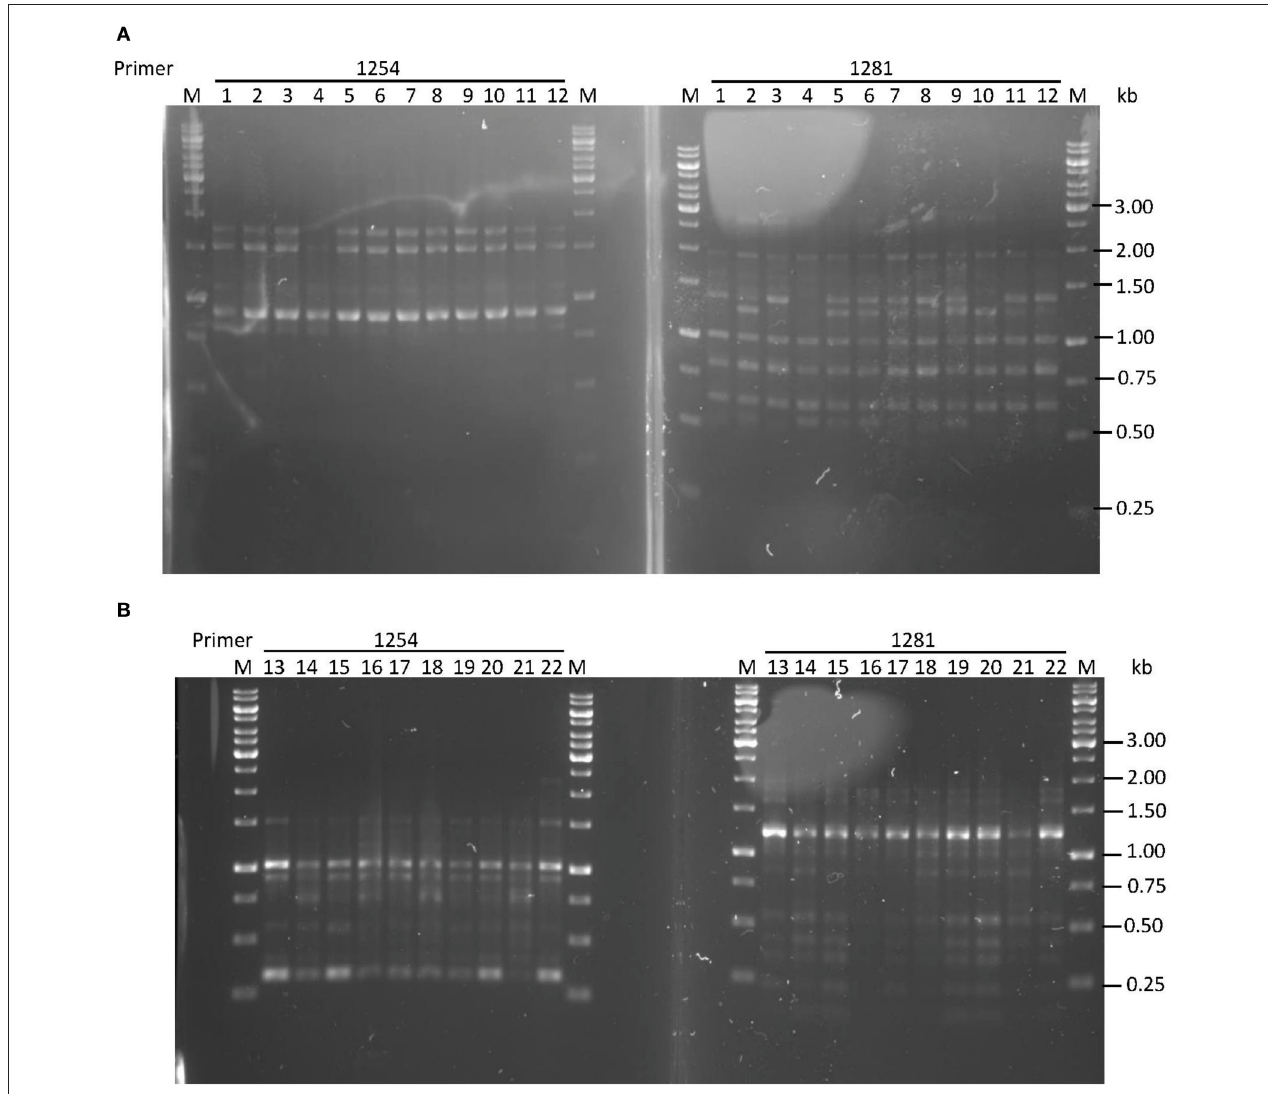
FIGURE 2 | RAPD-PCR typing of (A) levofloxacin-induced H. pylori UM137 strains 1–8 sensitive, 9–12 resistant (B) metronidazole dual population of H. pylori UM163 strains 13–19 sensitive, 20–22 resistant. Primers used were 1254 and 1281, and M: 1 kb DNA ladder.